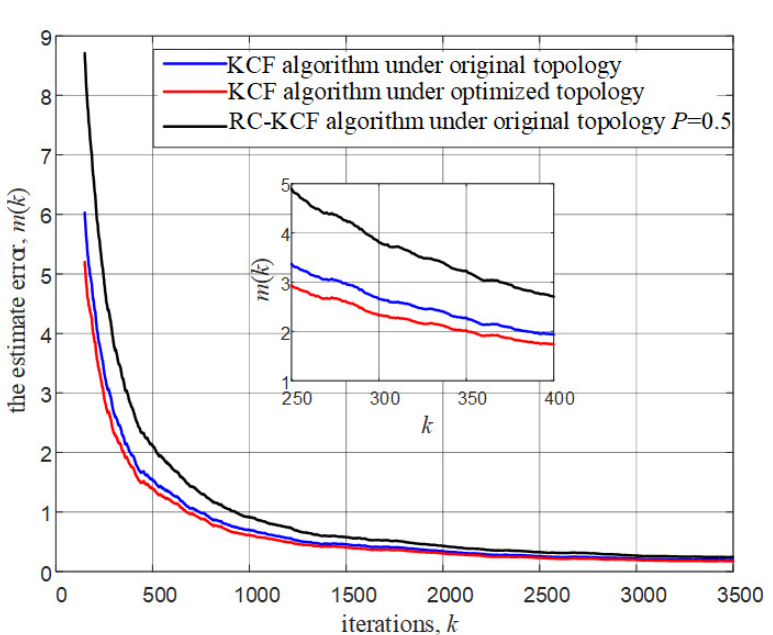
Figure 6. The mean square estimate error.